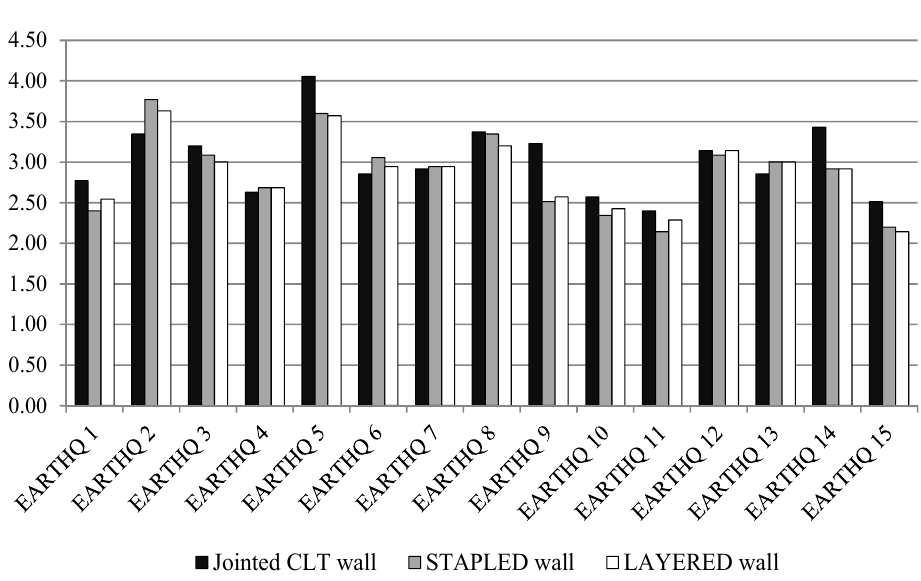
Figure 20. Values for q -factor.